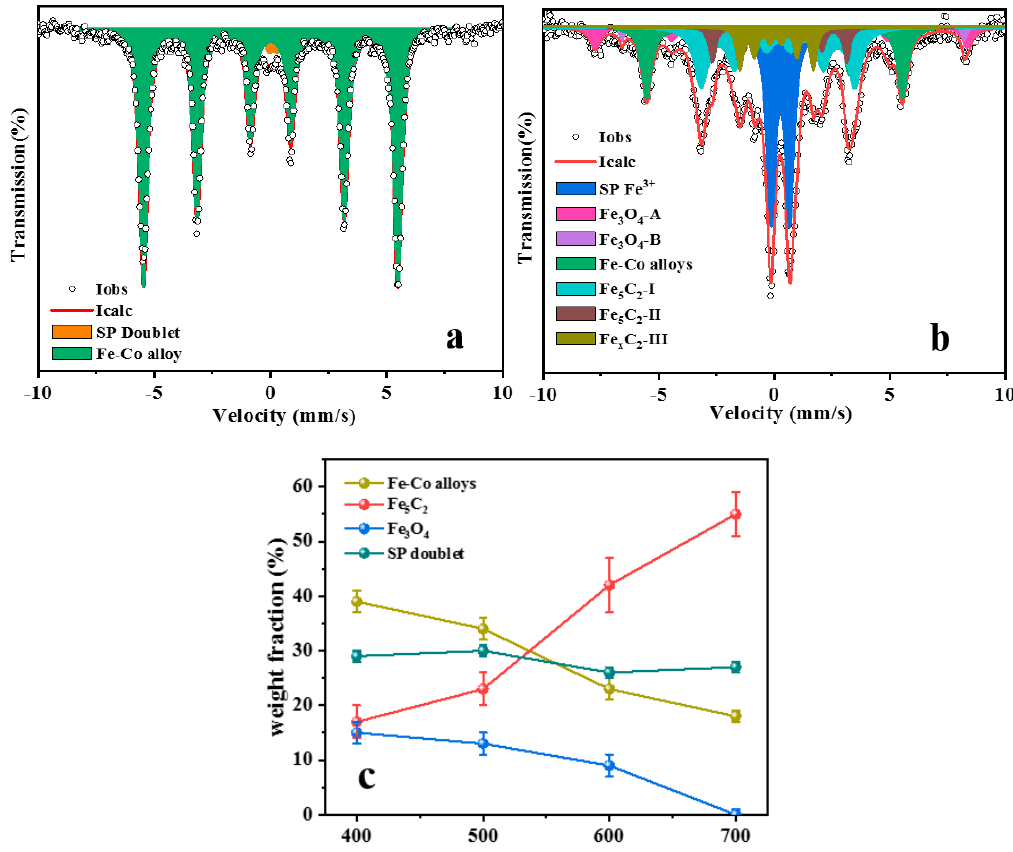
Figure 9. 57 Fe Mössbauer spectra of FeCo / NC-600 catalysts tested at room temperature before ( a ) and Figure 9. 57 Fe M ӧ ssbauer spectra of FeCo/NC-600 catalysts tested at room temperature before ( a ) and after ( b ) reaction and ( c ) the variations of di ff erent iron phases content in spent catalysts as a series of after ( b ) reaction and ( c ) the variations of different iron phases content in spent catalysts as a series of pyrolysis pyrolysis temperatures.